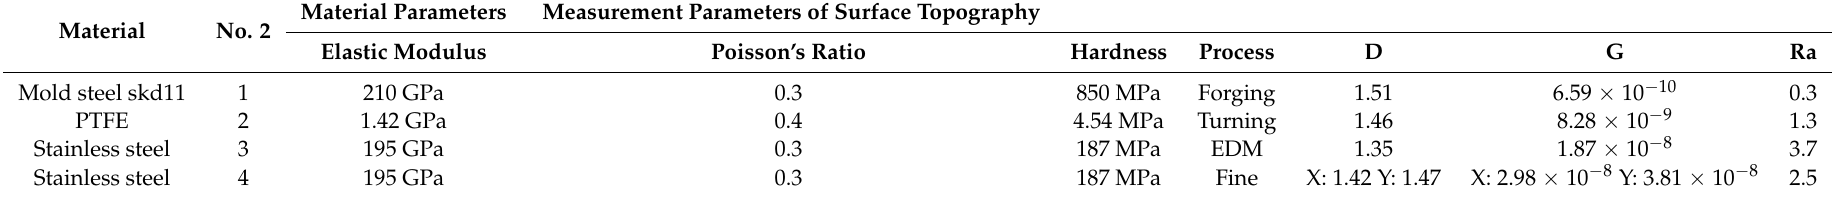
Table 1. Material and surface topography parameters of the test